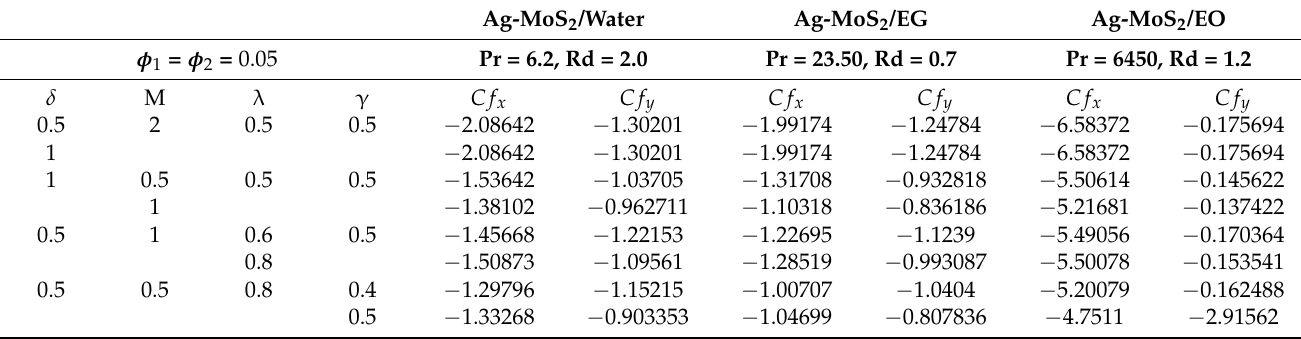
Table 1. The skin friction ( Cf x , Cf y ) results for the Ag-MoS 2 /H 2 O, Ag-MoS 2 /EO, Ag-MoS 2 /EG) hybrid nanofluids.